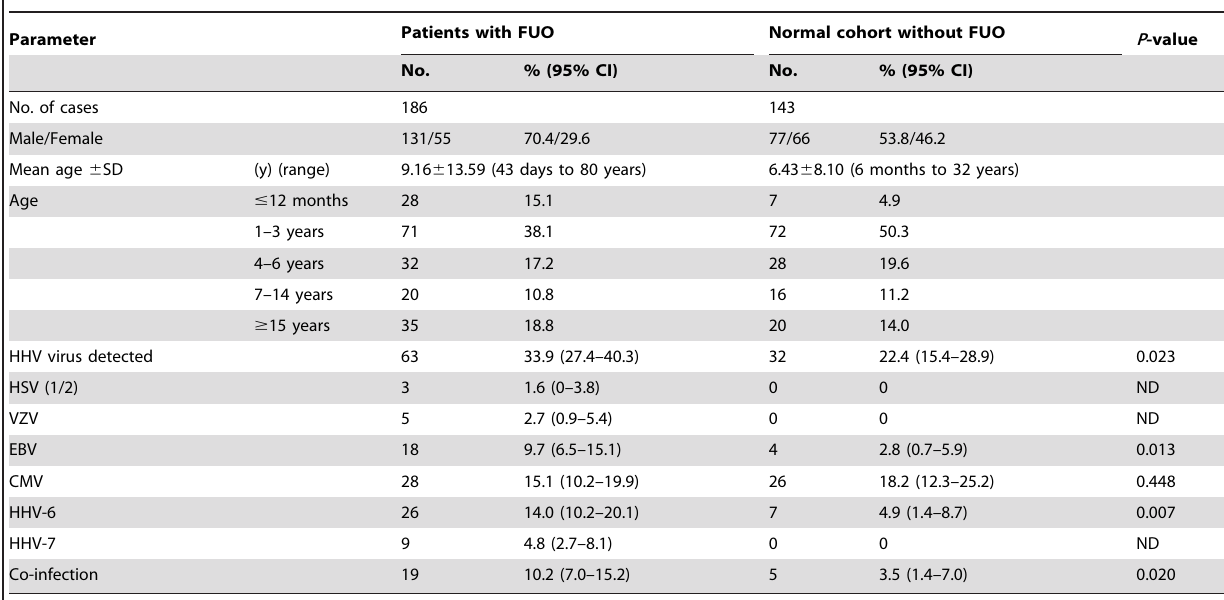
Table 2. Demographic and aetiological